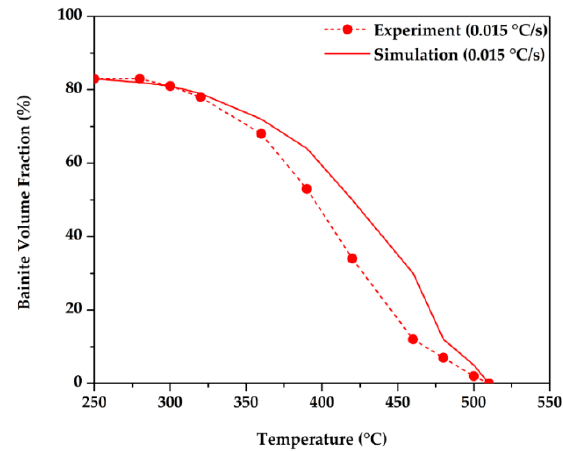
Figure 15. Comparison between the calculated bainite volume fraction and measured data on the forged block: Bainite volume fraction at 0.015 °C/s.